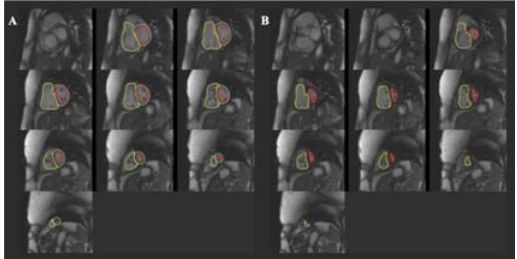
Figure 6. Right ventricular volumes obtained with cardiac magnetic resonance in a patient affected by pulmonary hypertension. ( A ) End-diastolic volume; ( B ) End-systolic